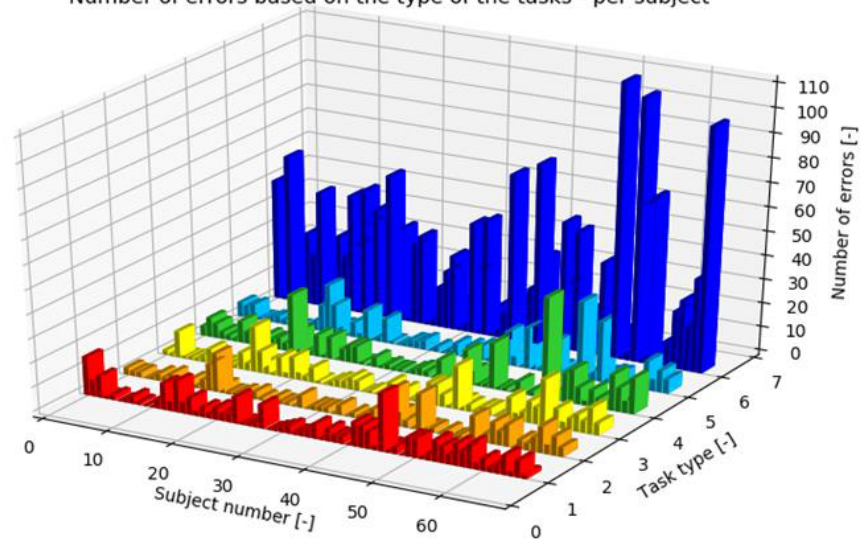
Figure 14. Number of errors based on the type of tasks — per subject.